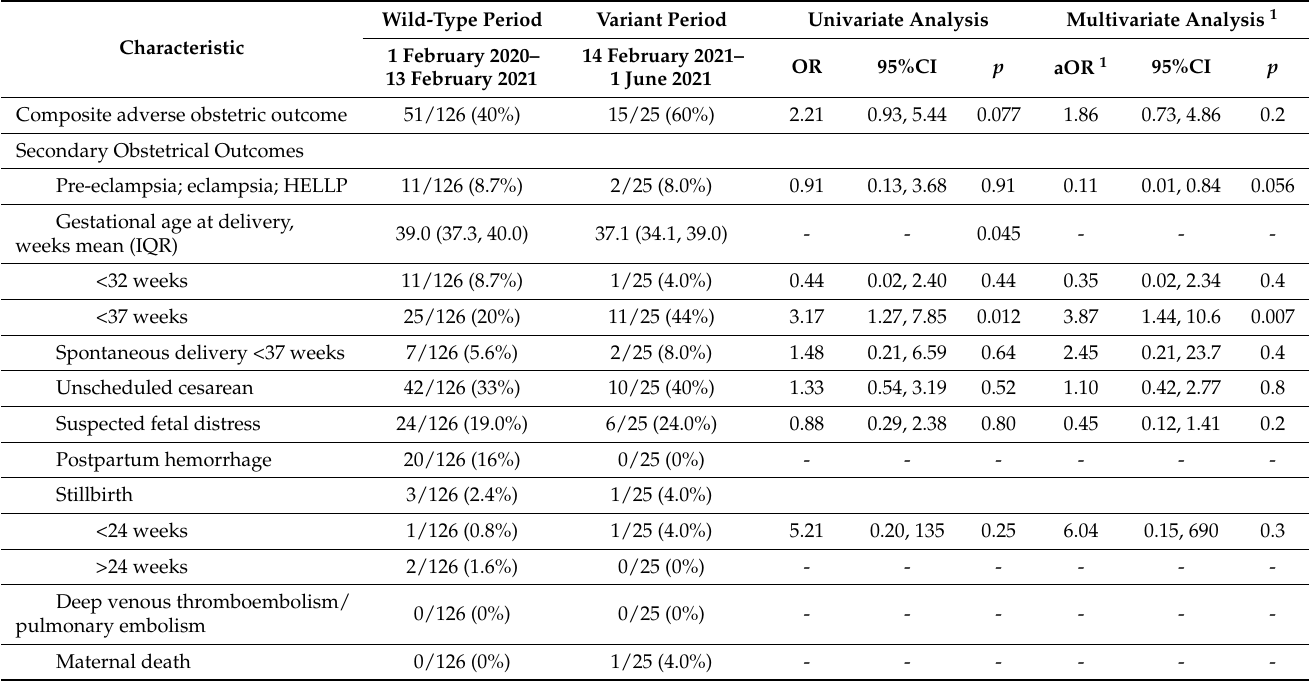
Table 3. Obstetrical outcomes among symptomatic pregnant women during the “wild-type period” and “variant